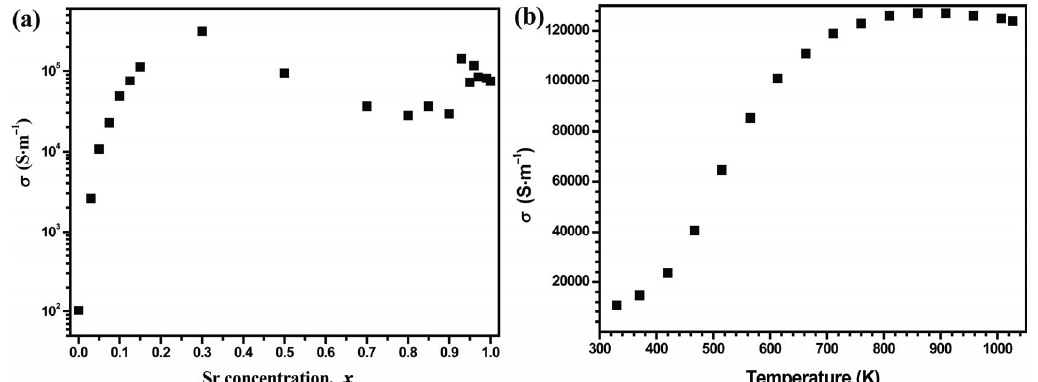
Fig. 7 Electrical conductivity ( σ ) for La 1– x Sr x CoO 3 with (a) 0 ≤ x ≤ 1 at 330 K and (b) x = 0.05 at different